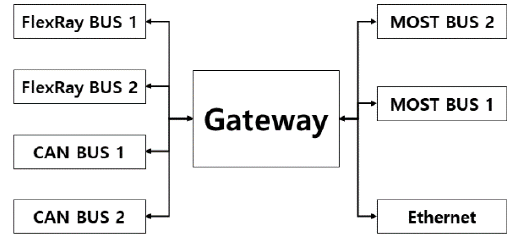
Figure 10. The simulation Model.